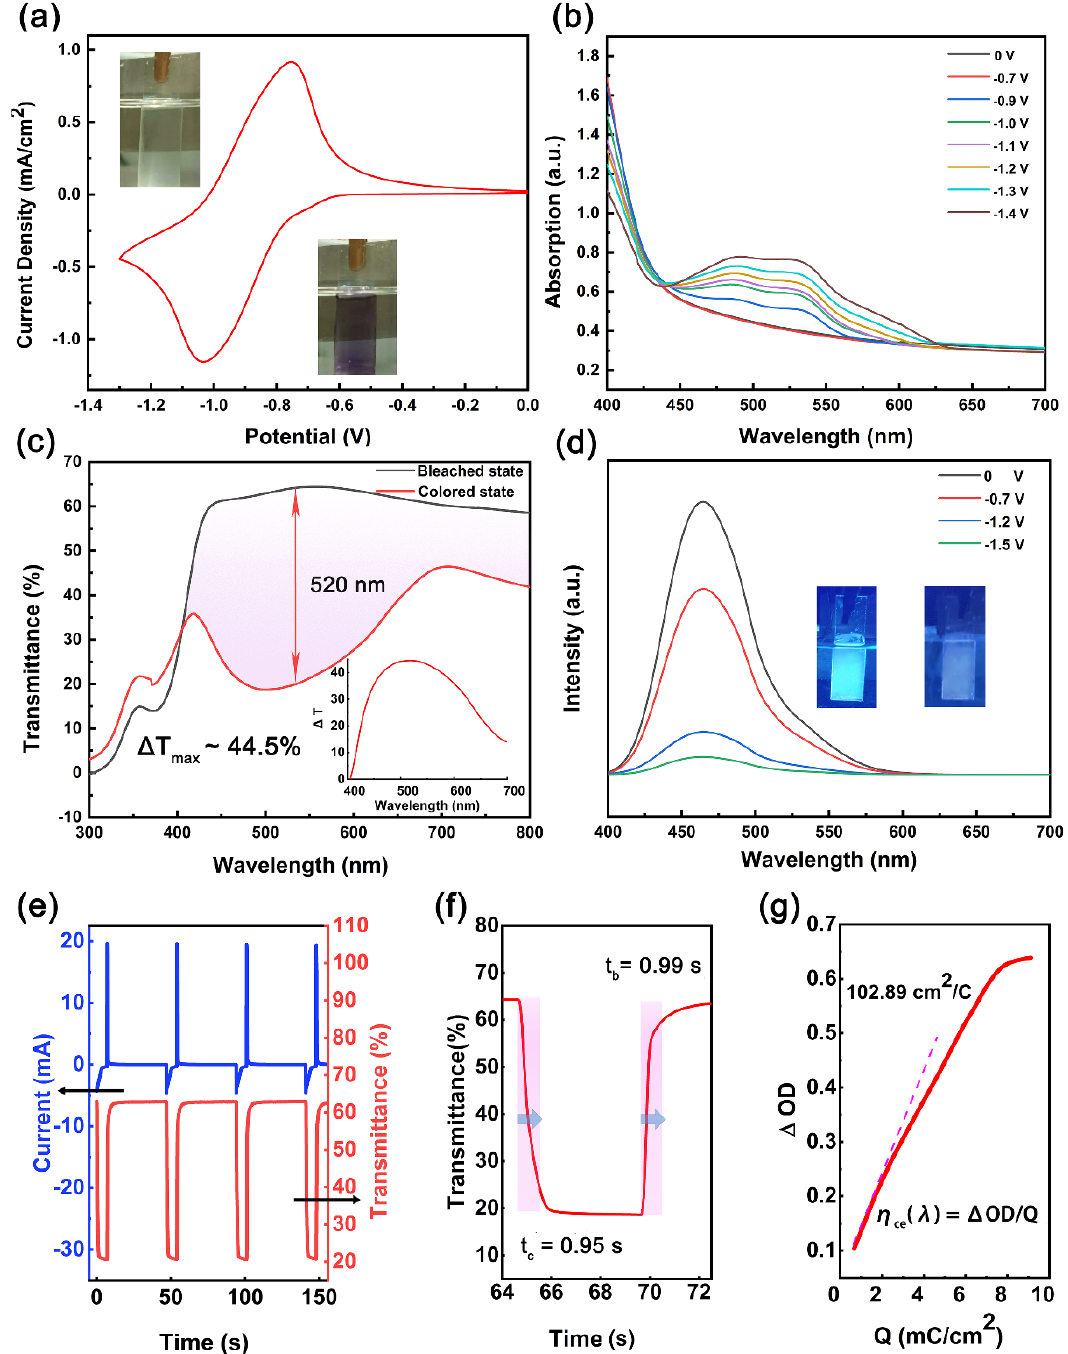
Figure 5. ( a ) The cyclic voltammogram of Zn − Oxv fi lms (scan rate of 100 mV s − 1 ). ( b ) Spectroelectro- chemical spectra of Zn − Oxv fi lms under di ff erent external potentials. Inset: photographs of Zn − Oxv thin films at colored and bleached states. ( c ) The transmi tt ance spectrum of Zn − Oxv fi lms at colored and bleached states. Inset: transmittance differences between colored and bleached states. ( d ) Fluo- rescence intensity differences between the fluorescent and nonfluorescent states. Inset: photographs of Zn − Oxv fi lms at fl uorescent and non fl uorescent states. ( e ) Variation of current and corresponding transmittance switching spectra (recorded at λ = 520 nm) with applied square wave used for color switching of Zn − Oxv thin fi lms. ( f ) Transmittance switching between colored and bleached state. ( g ) The coloration e ffi ciency of Zn − Oxv thin fi lms.